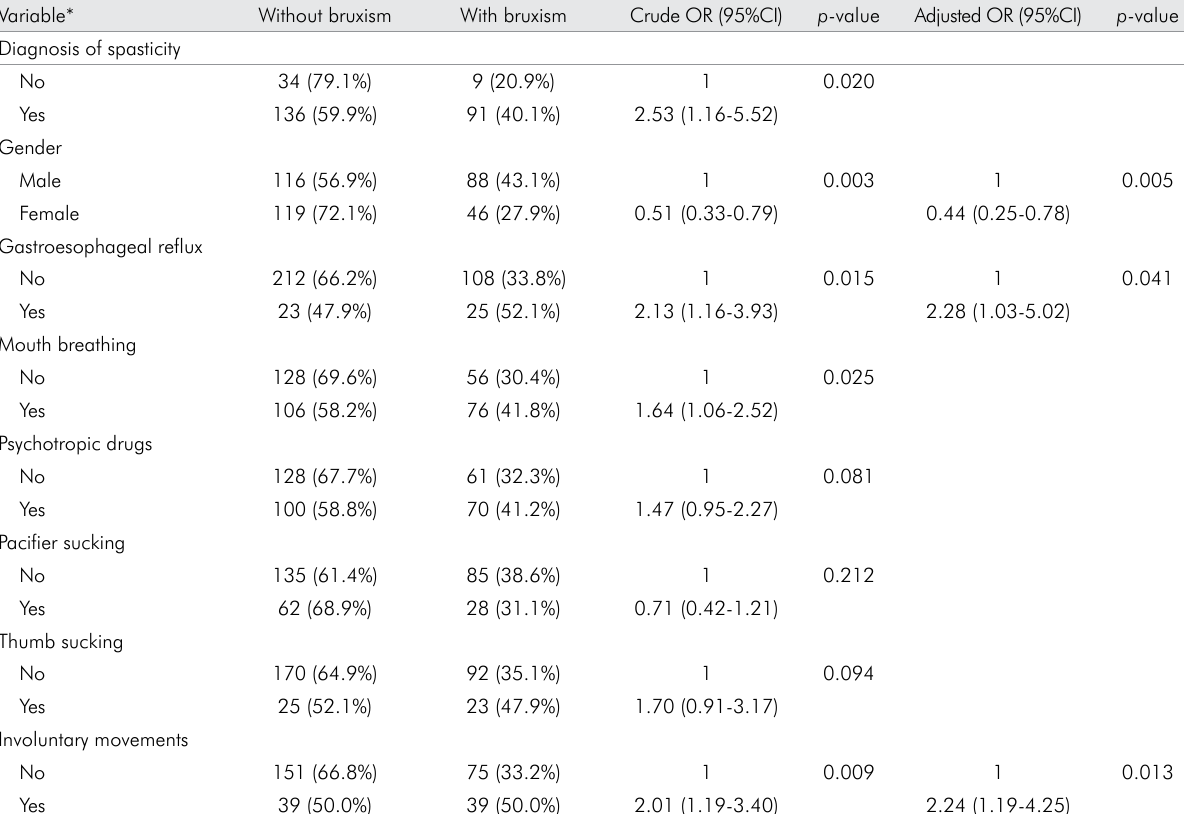
Table 1. Associations between reported bruxism and independent